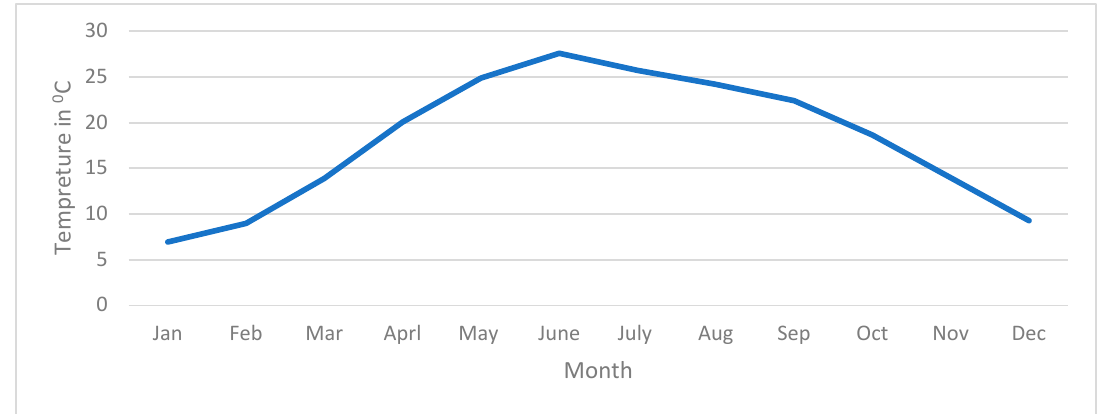
Figure 3. Average monthly temperature in Mirpur, Pakistan.